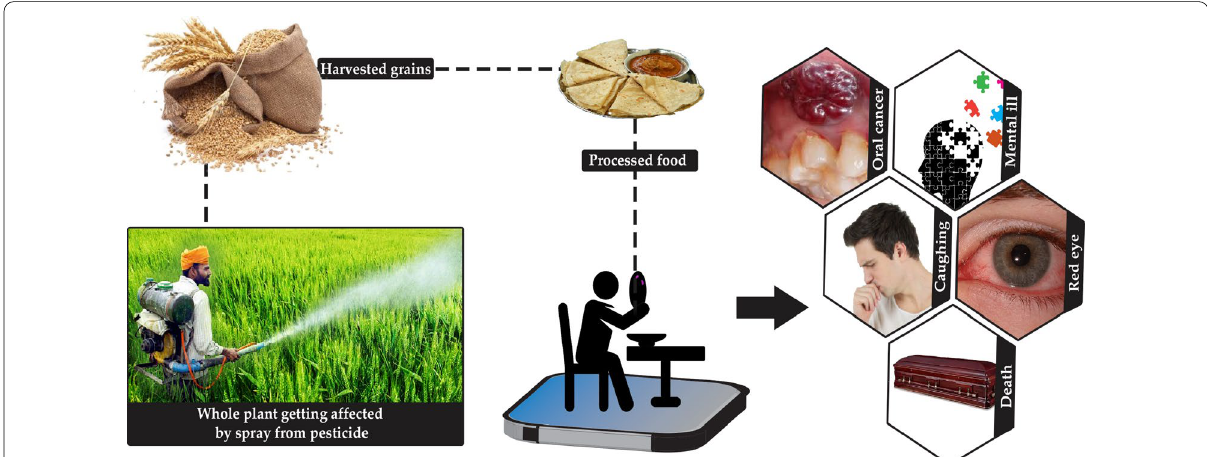
Fig. 4 Adverse effects of pesticides on human